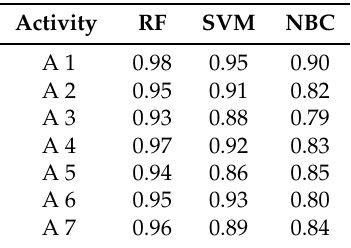
Table 3. Accuracy of different classification algorithms in an line-of-sight (LOS)